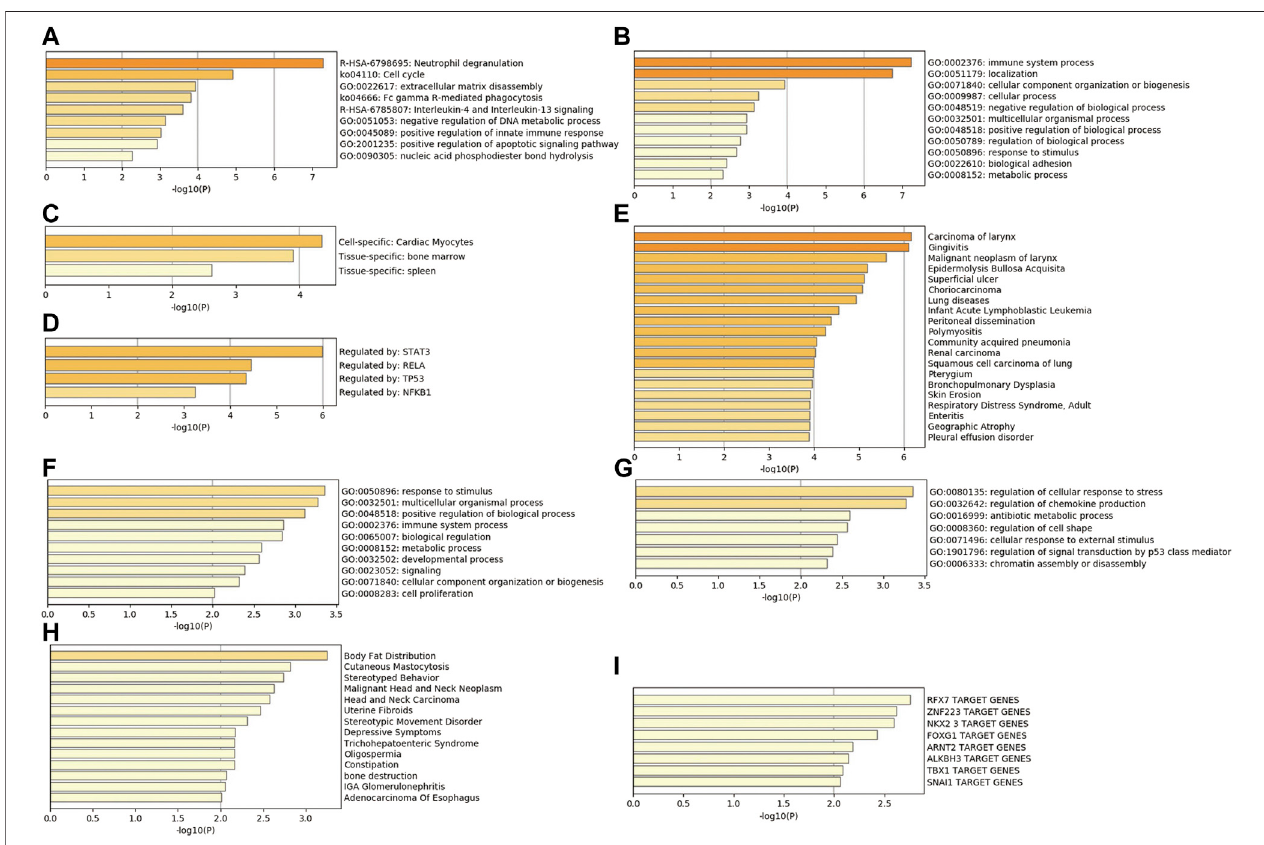
FIGURE 4 | Comprehensive database analysis. (A,B) Biological functions of upregulated genes analyzed through Metascape database; (C) tissue and cell characteristics of upregulated genes in PaGenBase database; (D) enrichment of transcriptional regulators of upregulated genes in TRRUST database; (E) DisGeNET database enrichment analysis of diseases involving upregulated genes; (F,G) Biological functions of downregulated genes analyzed through Metascape database; (H) DisGeNET database enrichment analysis of diseases involving downregulated genes; (I) enrichment of transcriptional regulators of downregulated genes in TRRUST